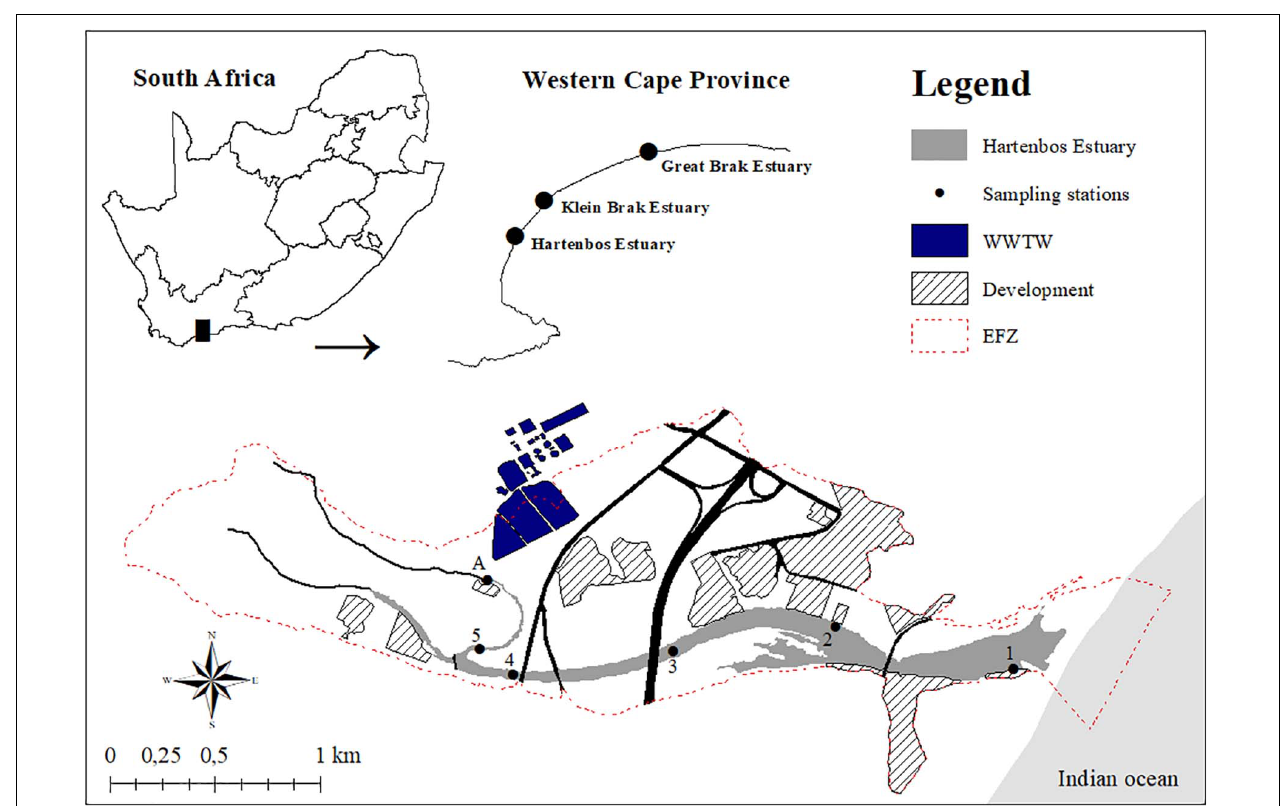
FIGURE 1 | Distribution of the sampling stations, wastewater treatment works (WWTW), and urban developments within the estuarine functional zone (EFZ) of the temporarily closed Hartenbos Estuary, South